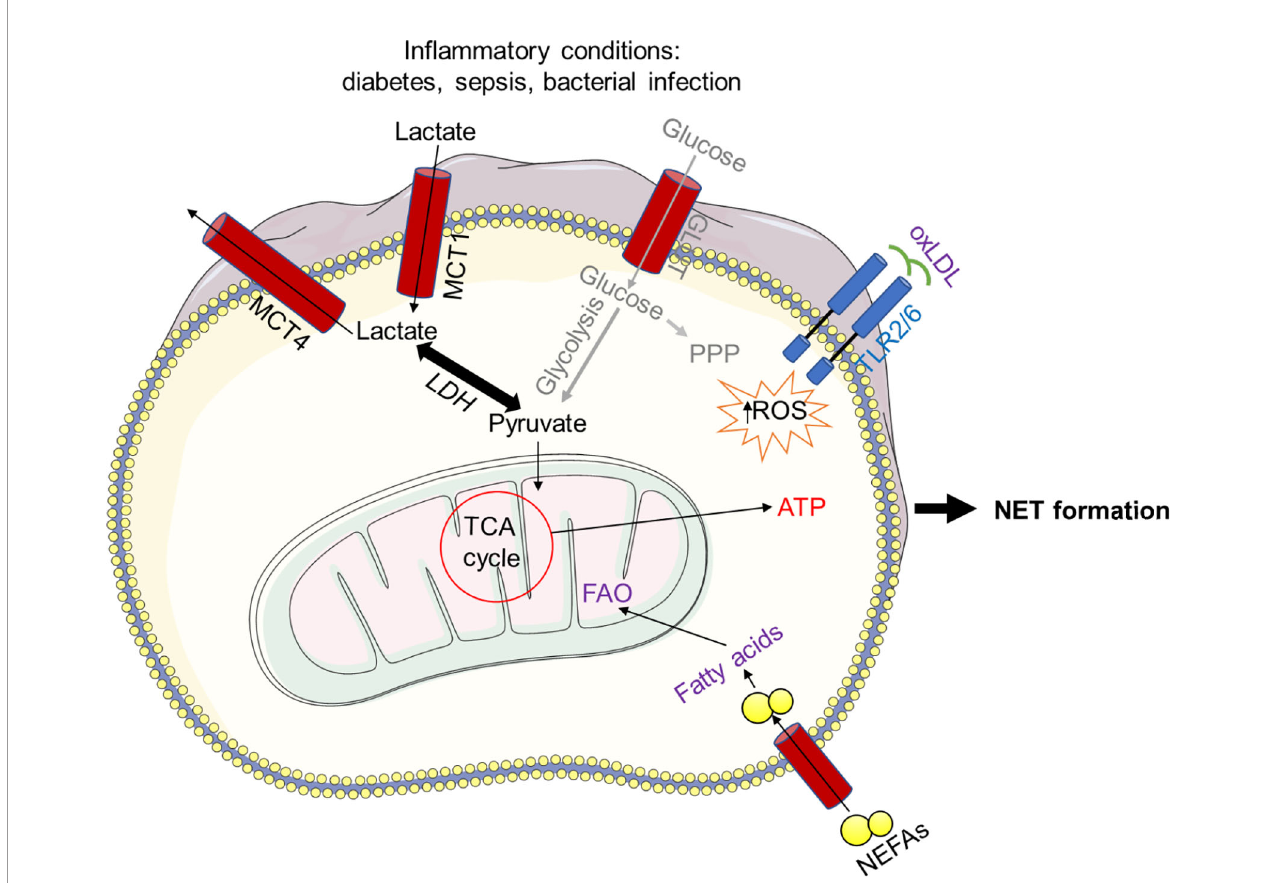
FIGURE 6 | Bacterial lactic acid generated during infection can induce NET formation. Bacteria-produced lactic acid can cause NET formation in bovine neutrophils, and inhibiting the lactate transporter, the mono-carboxylate or lactate dehydrogenase (LDH) enzyme, prevents this. Because LDH can convert both pyruvate and lactate, it is possible that neutrophils use lactate during NET formation and glycolysis to circumvent the PPP. Furthermore, NET formation in human neutrophils is caused by oxidized low-density lipoprotein (oxLDL) in a ROS-dependent manner upon TLR activation. In addition, non-esteri fi ed fatty acids (NEFAs), such as oleic acid (OA) and linoleic acid (LA), initiate FAO, allowing increased ATP production and consequently NET